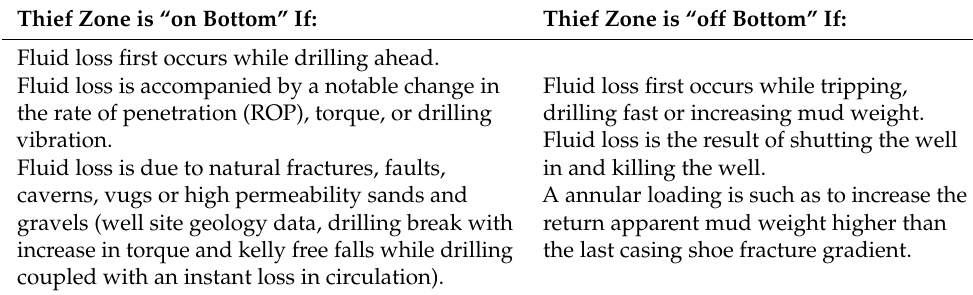
Table 1. The probable location of the thief zone according to